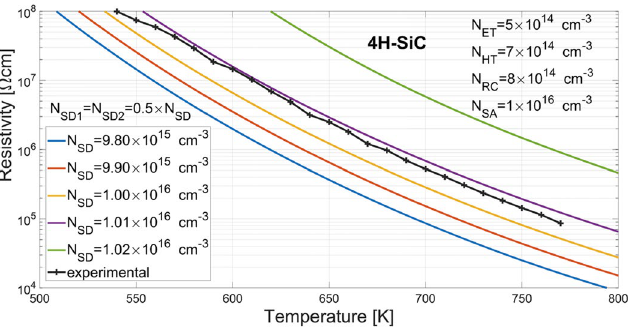
Figure 13. Comparison results of measurements and simulations of dark resistivity in a range of temperature from 540 to 770 K at 10 K